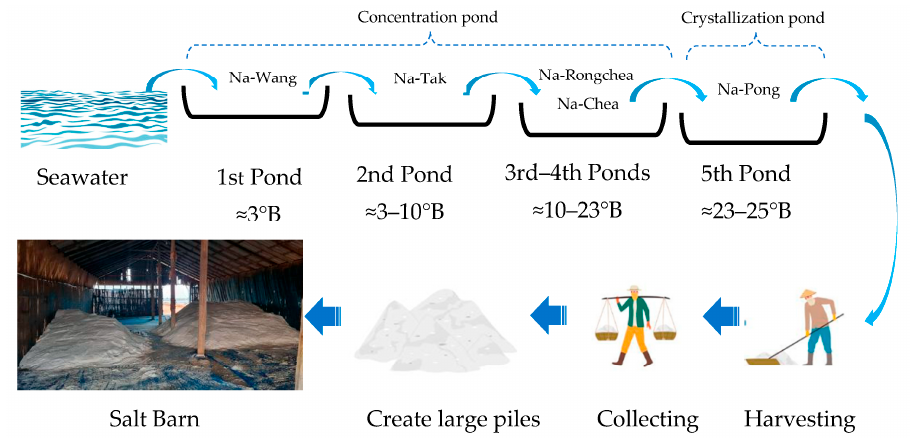
Figure 1. Sea salt production in Thailand.